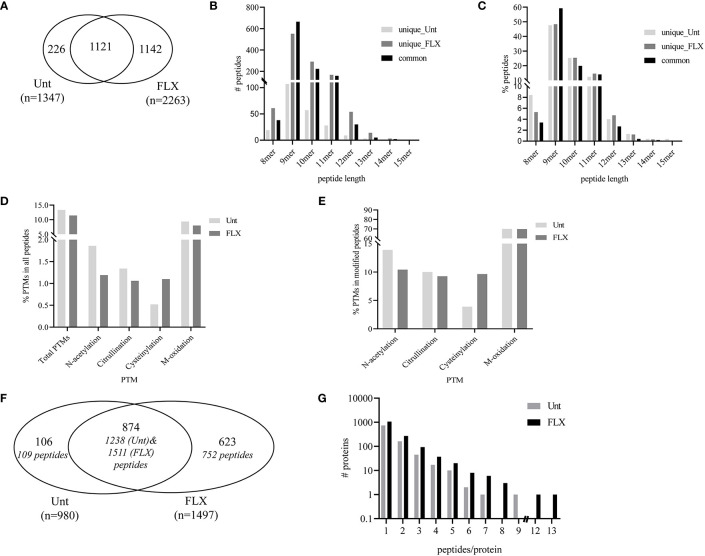
Flucloxacillin (FLX) treatment induces diversity in the peptide repertoire of B721-5701 cells. Common and unique peptides eluted from human leukocyte antigen (HLA)/peptide complexes obtained from two independent cultures of untreated B721-5701 cells (Unt) and of cells treated with 150 μg/ml of FLX (FLX) for 5 days were combined for the analysis (A). Absolute counts (B) or frequency (C) of 8–15 amino acid peptides. Frequency of peptides with post-translational modification (PTM) within the peptide repertoire (D) or among modified peptides (E). Common and unique proteins represented by immunopeptidome-contained sequences (in
Figure 2A
) (F). Protein distribution showing the number of peptides per protein (G). Data analysis was performed using Peaks 8.5 and X software. The datasets of peptides in the B721-5701 peptidomes are provided in
Table S2A, B
.